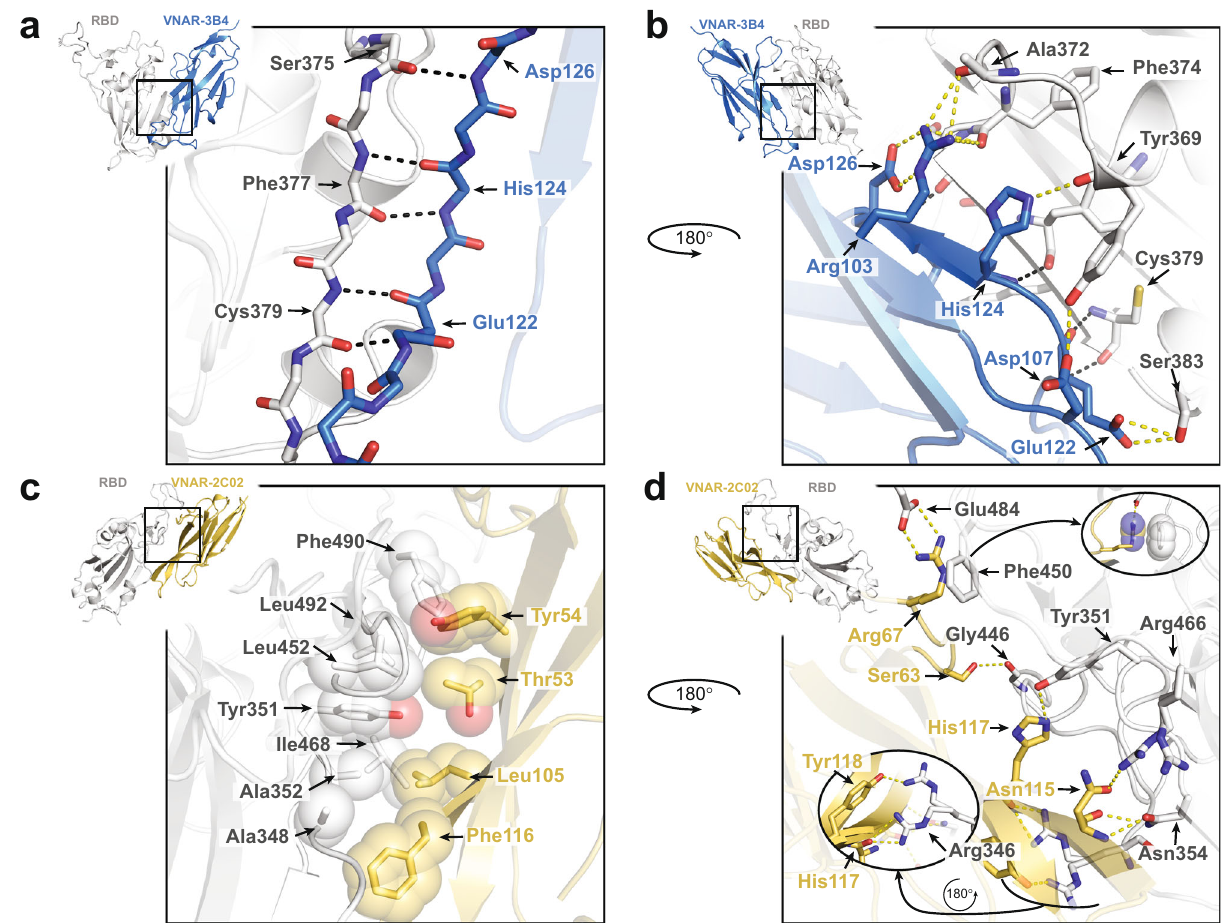
Fig. 4 VNARs 3B4 and 2C02 bind the SARS-CoV-2 RBD through uniquely different interactions. a Stick representation of the peptide backbone in the primary interaction interface. Interactions between residues Ser-375, Phe-377 and Cys-379 of the RBD (white) and Glu-122, His-124, and Asp-126 of 3B4 (blue) are shown as black dashes. Inset shows the orientation of the zoomed in view. b A 180-degree view of the interaction interface. Interactions between residues of the RBD (white) and 3B4 (blue) are shown as yellow dashes with black dashes. Inset shows the orientation of the zoomed in view. c Transparent spheres surrounding the stick representations of residues involved in the hydrophobic interactions between the RBD (white) and VNAR- 2C02 (yellow). Inset shows the orientation of the zoomed in view. d A 180-degree view of the interaction interface between the RBD (white) and 2C02 (yellow). Residues are shown as sticks with yellow dashes representing hydrogen bonds between atoms. Rounded insets show an alternate view of interactions that are partially obscured from view in the main panel. Top inset shows the orientation of the zoomed in